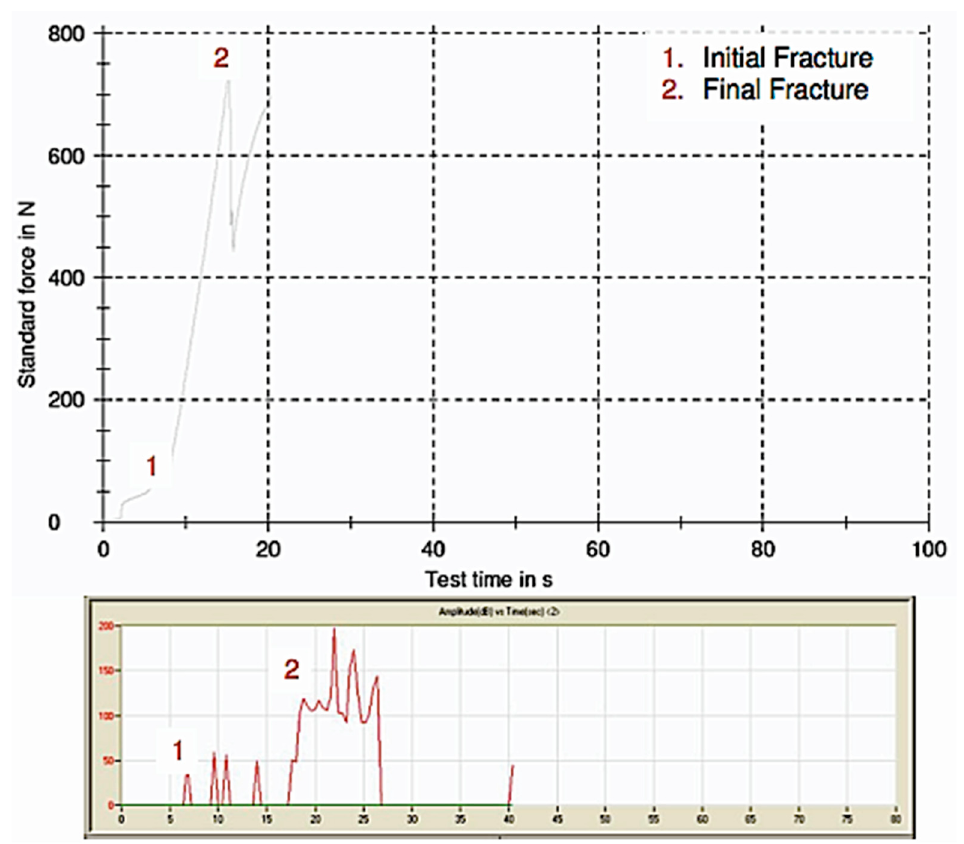
Figure 2. Graphs of the load-time relationship and amplitude-time relationship produced by the Zwick and AE sensor respectively. Please provide us a higher resolution picture. Figure 2 is not mentioned in the text of manuscript. Please check and revise.